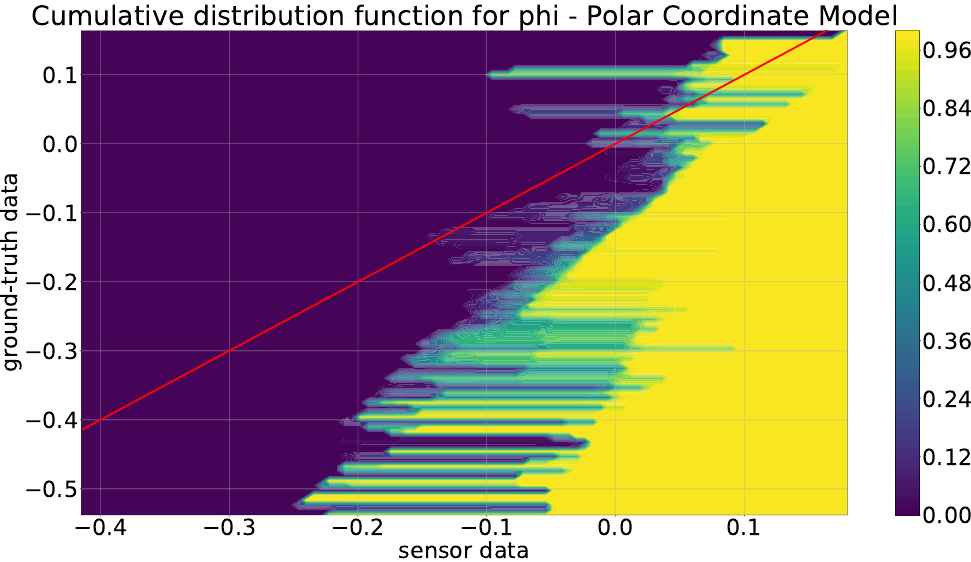
Figure 14. Cumulative distribution function for the polar coordinate model for the angle φ (deg).